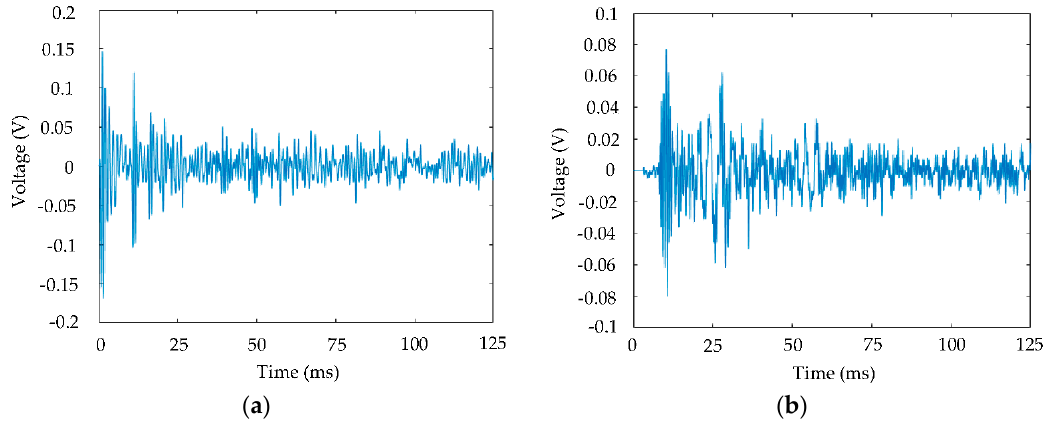
Figure 13. Impulse response signals acquired at different distances from sensor 1: ( a ) 0.4m and ( b ) 13m.